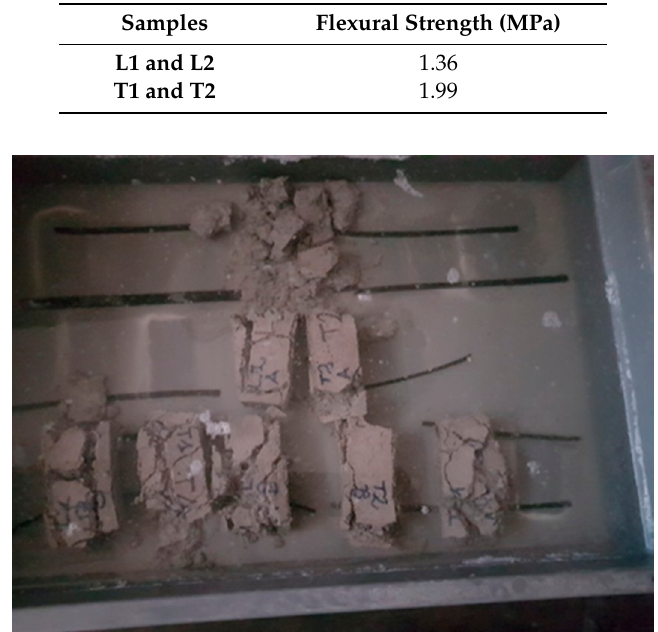
Table 10. Flexural strength results after salt crystallisation cycle on specimens L1, L2, T1 and T2.